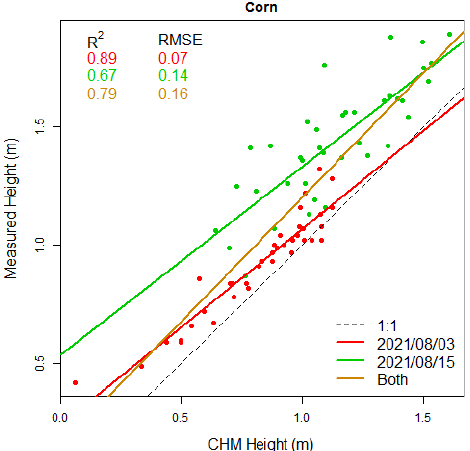
Figure 8. Linear regressions between the crop height models (CHMs) and geo-located field height measurements of corn.